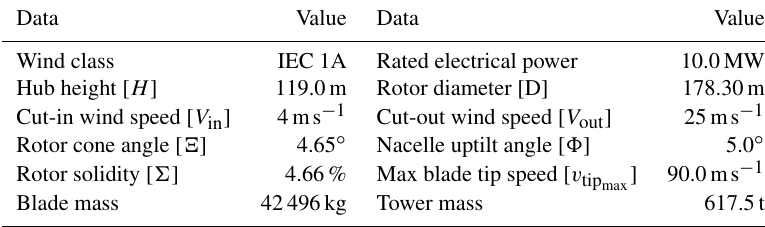
Table 2. Principal characteristics of the full-scale 10MW wind turbine (Bottasso et al., 2016).